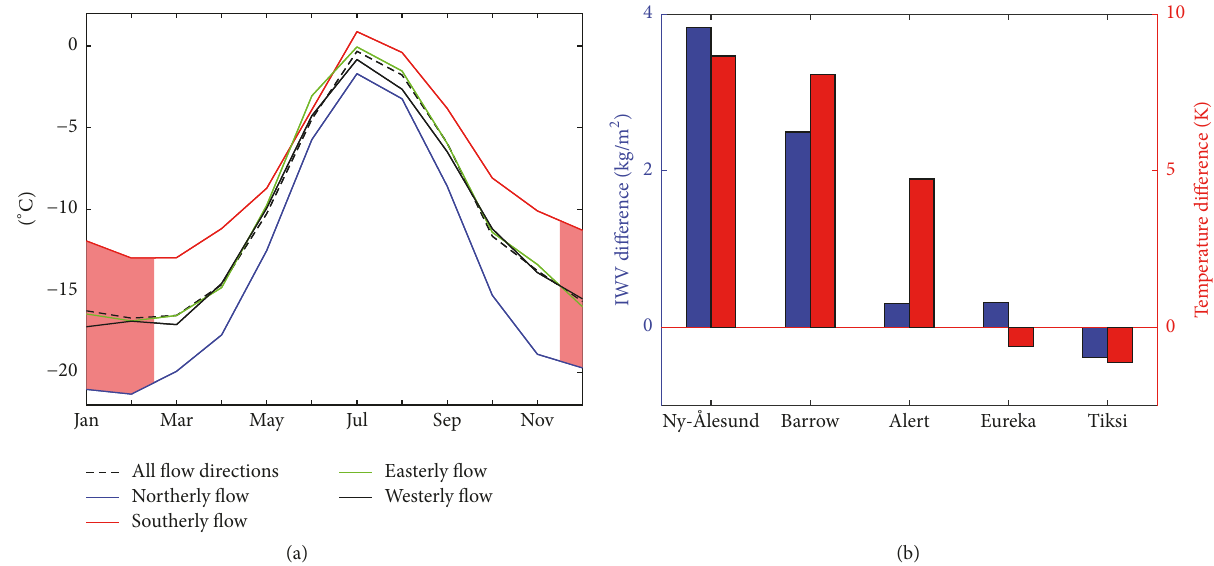
Figure2:(a)Ny-˚Alesundtemperaturefromradiosondes1993to2016averagedbetween800and850 hPafordifferentflowdirections.Cardinal wind directions were defined as perfect ± 45 ∘ and at least 75% of winds in the layer had to be within that range. The S − N difference during DJF is shaded. (b) S − N difference in temperature (red, averaged between 800 and 850 hPa) and water vapor content (IWV, blue, vertically integrated up to 200 hPa) for different Arctic locations from the ERA-Interim reanalysis during